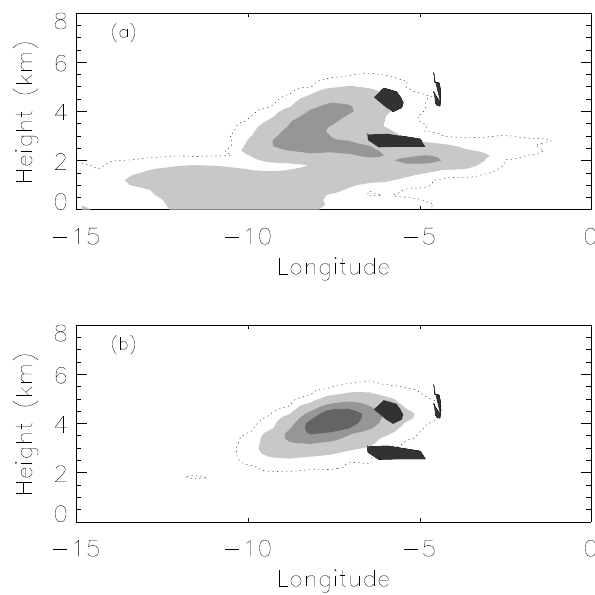
Fig. 5. Cross sections of ash concentration taken along aircraft tracks from NAME simulations for the 4 and 5 May. (a) 4 May, uniform emission profile (b) 5 May, uniform emission profile and (c) 5 May, emissions at top of plume. The dark grey shaded areas show the outlines of ash features identified by the lidar. The dotted contour corresponds to a concentration of 2µgm − 3 and is taken to show the edge of the ash cloud. The filled contours correspond to 20, 200, and 200µgm − 3 (note these concentrations do not account for fall out of ash near the volcano).